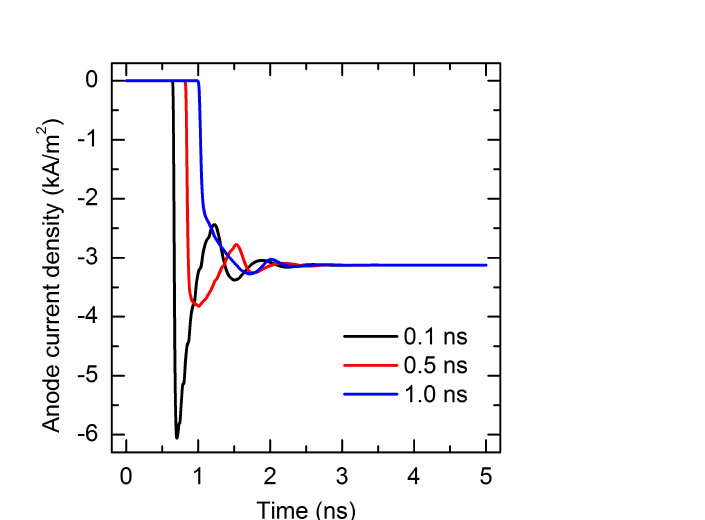
Figure 2 – Time profiles of the diode current density given at various risetimes Рис. 2 – Временные профили плотности тока диода при различных